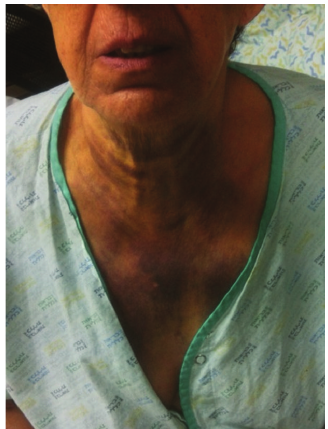
Figure 2: Angiography of the cervical arteries. Conventional angiography demonstrates typical “strings of beads” in the right ICA (black arrows) without active bleeding.